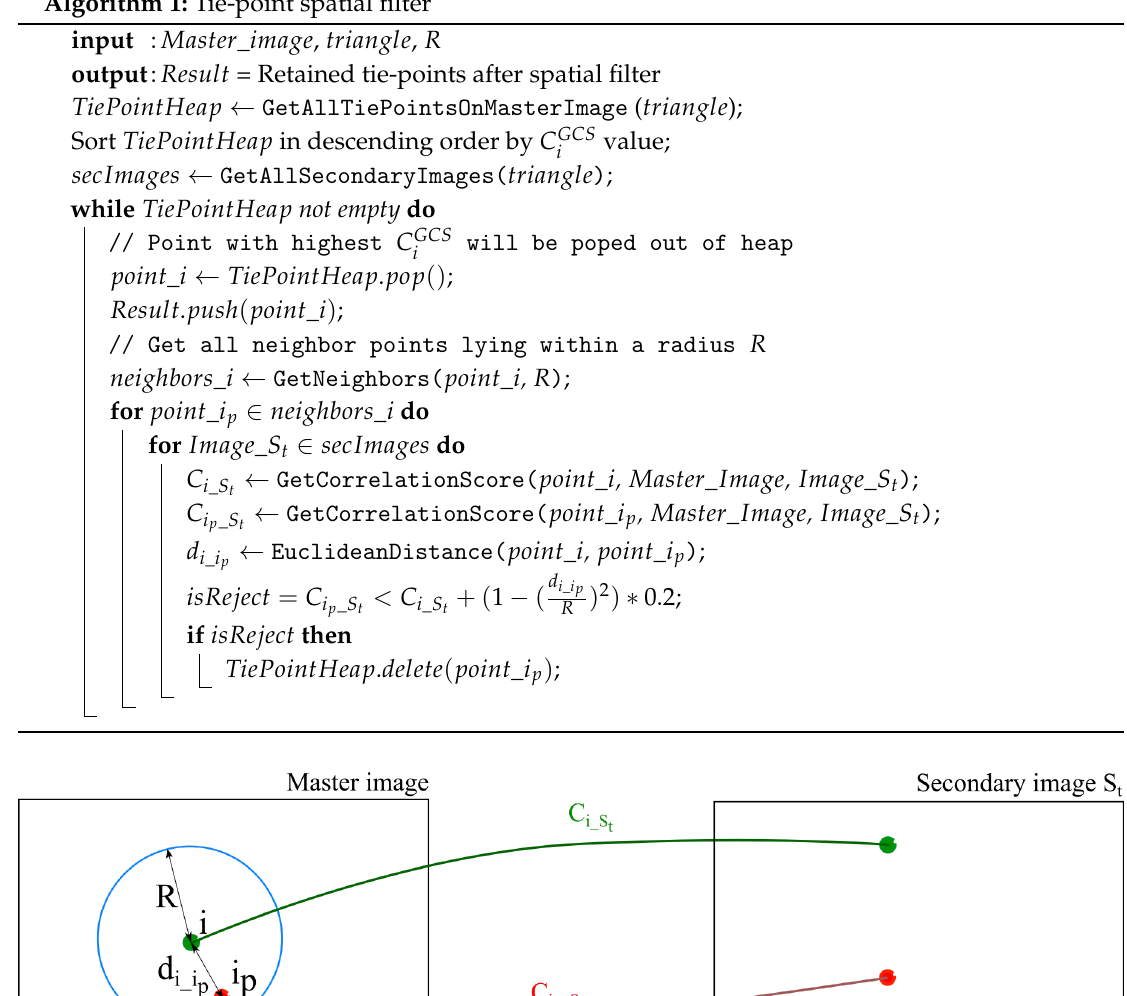
: ( Left ): matched points i